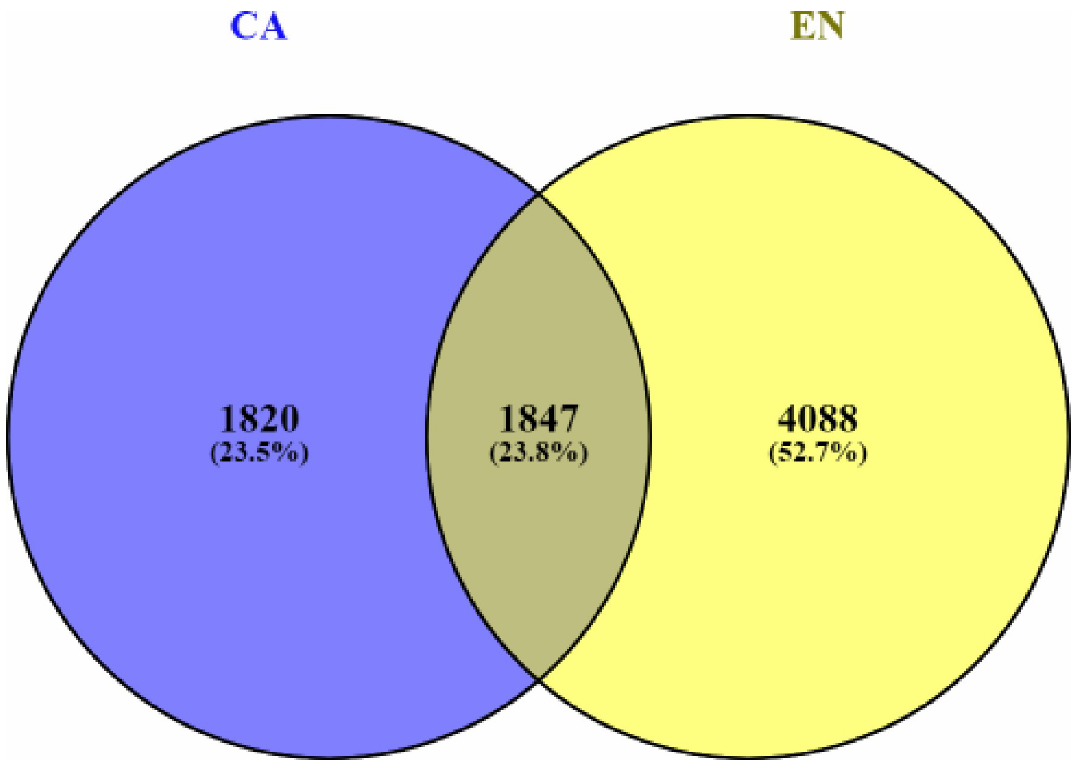
Fig 2. Venn diagram of differentially expressed genes. Graphical representation of the overlap of differentially expressed genes by group (FDR P-Value < 0.05). Includes genes which were differentially expressed in chorioallantois (CA), and endometrium (EN) across